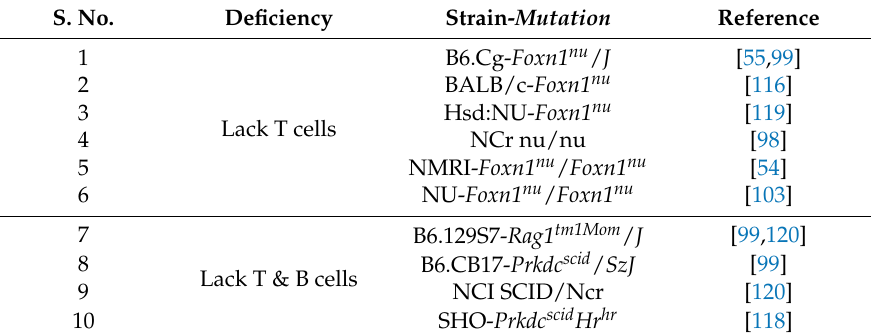
Table 2. List of immunodeficient mice found to be susceptible to MmuPV1 skin infections. S. No. Deficiency Strain- Mutation Reference 1 B6.Cg- Foxn1 nu / Lack T cells